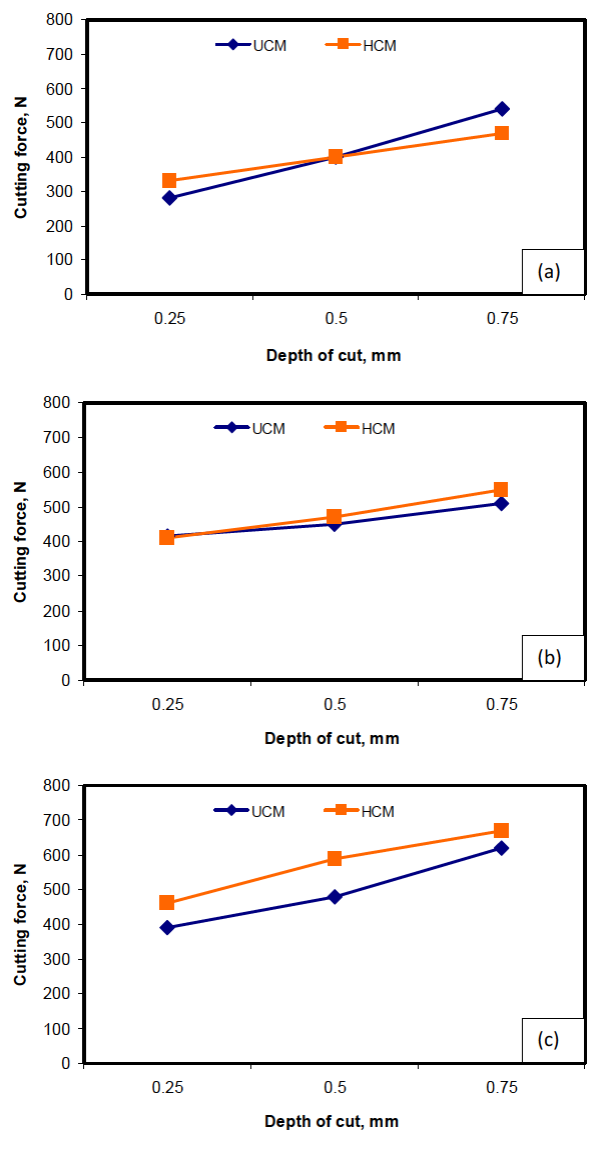
Figure 3: Variation of cutting force with depth of cut, (a) cutting speed 95 m/min, feed 0.05 mm/rev (b) cutting speed 125 m/min, feed 0.05 mm/rev (c) cutting speed 175 m/min, feed 0.05